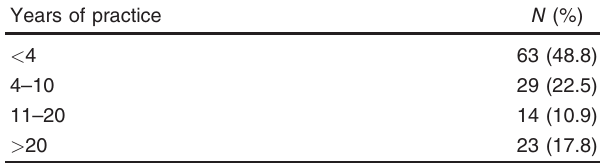
Table 4 Description of doctors according to years of practice